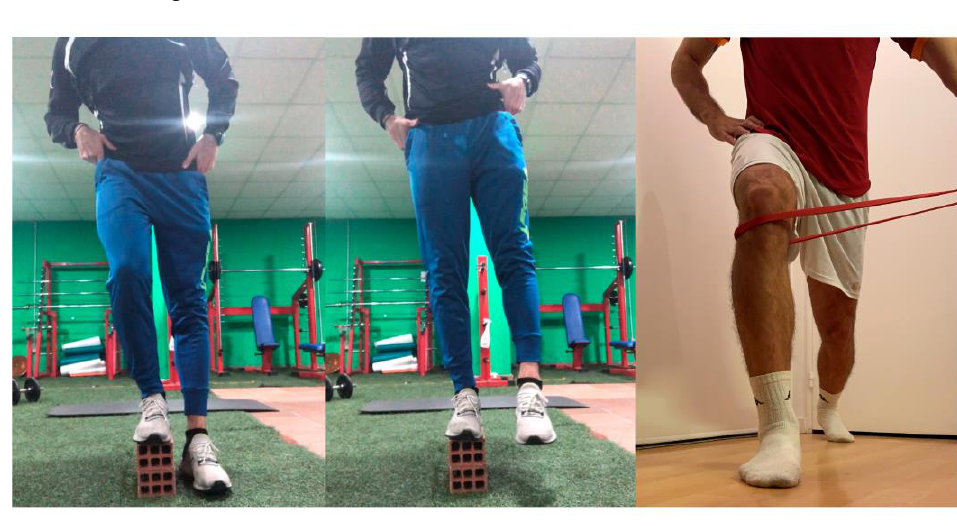
Figure 2. show the three exercises. Figure 2. Show the three exercises.